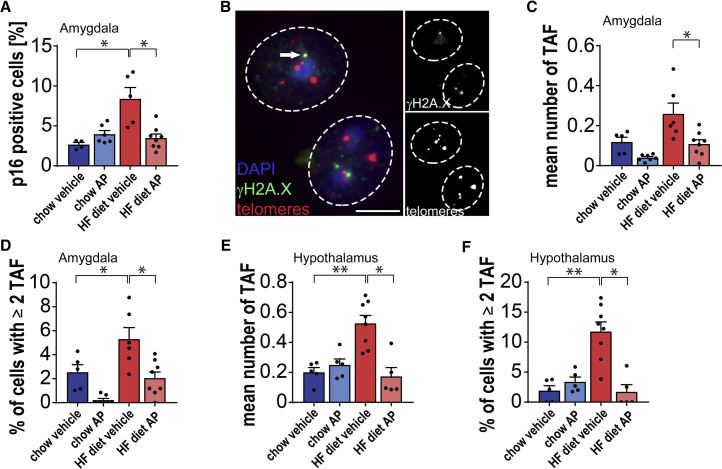
Markers of Senescence in the Amygdala Are Reduced after Treatment with AP20187(A) p16-positive cells were measured by RNA-ISH in the basomedial layer of the amygdala (t(9) = 2.627, p = 0.0275; t(12) = 2.918, p = 0.0129).(B) Representative images showing telomere-associated DNA damage foci (TAF), (blue = DAPI, red = telomeres, green = γ-H2A.X, white arrow indicates TAF; scale bars, 5 μm) in 3-μm-thick paraffin embedded brain sections.(C and D) (C) Mean number of TAF (t(9) = 2.221, p = 0.0535; t(12) = 2.874, p = 0.014) and (D) percentage of NeuNpos cells with 2 or more TAF (t(4.298) = 3.943, p = 0.0147; t(11) = 3.854, p = 0.0027) was increased in HFD INK-ATTAC mice and was significantly reduced after AP20187 treatment in the basomedial layer of the amygdala.(E and F) (E) Mean number of TAF (t(11) = 4.449, p = 0.001; U = 2, p=0.0062) and (F) percentage of NeuNneg cells with 2 or more TAF (t(11) = 4.501, p = 0.0009; U = 1, p = 0.0031) were increased in HFD INK-ATTAC mice and significantly reduced after AP20187 treatment in the hypothalamus in close proximity to the 3rd ventricle.Data are from n = 5–6 mice per group for (B)–(D); Mean ± SEM plotted. ∗p ≤ 0.05 and ∗∗p ≤ 0.001.